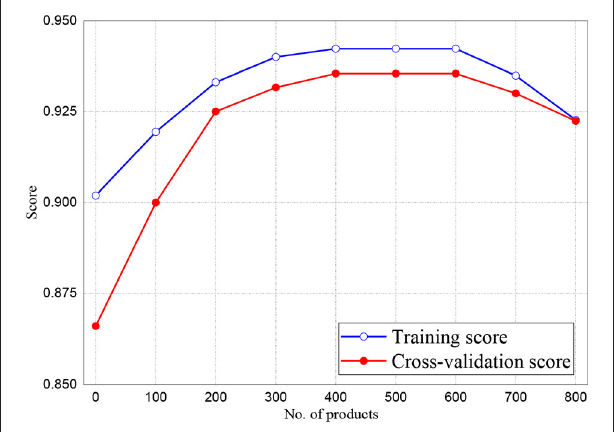
FIGURE 5 | Result for Training and Cross-Validation of MLP classifier.